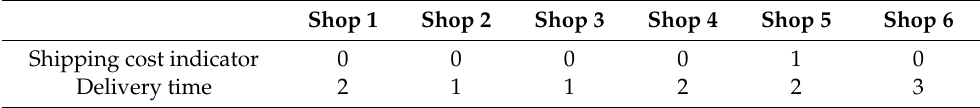
Table 12. The result of numerical solution